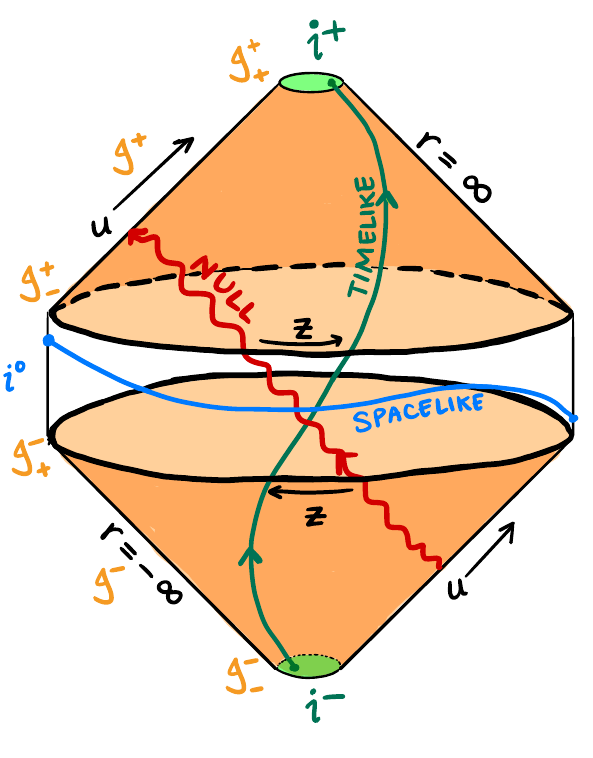
Figure 1 . Penrose Diagram of Minkowski